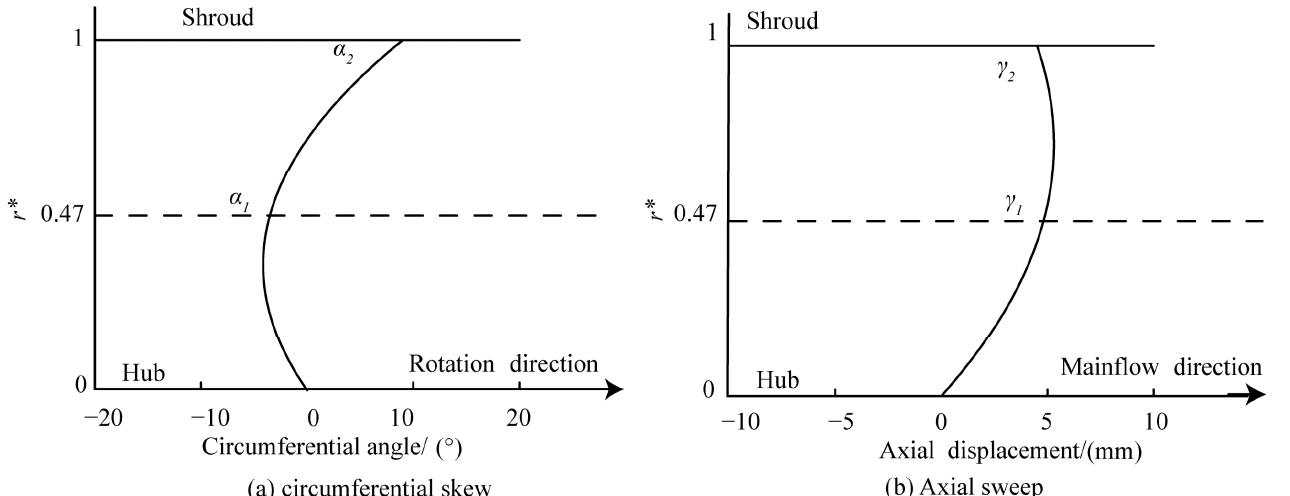
15 5.3. Optimization Progress The optimization process is shown in Figure 7. First, an optimized Latin hypercube sampling (OLHS) is used to obtain sample data within the design range. An automatic numerical simulation platform is built through Isight to quickly obtain the optimal target value of the sample point, and the approximate relationship between the variables and the optimization target is fitted through machine learning. After comparing the training results of the SVR, GPR, and FNN models, the appropriate approximate model is selected. Finally, the approximate model is solved using the multi-island genetic algorithm (MIGA)